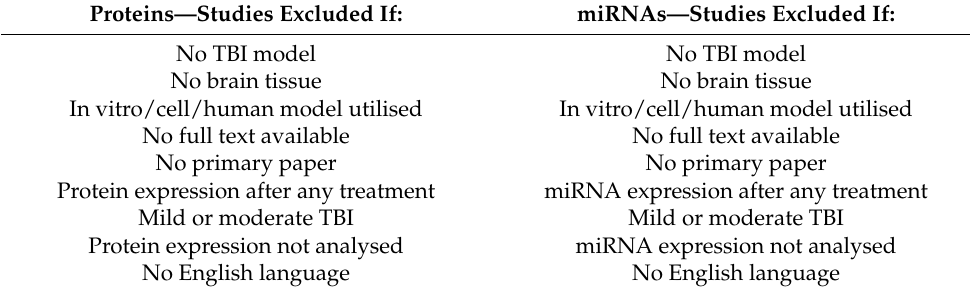
Table 2. Exclusion